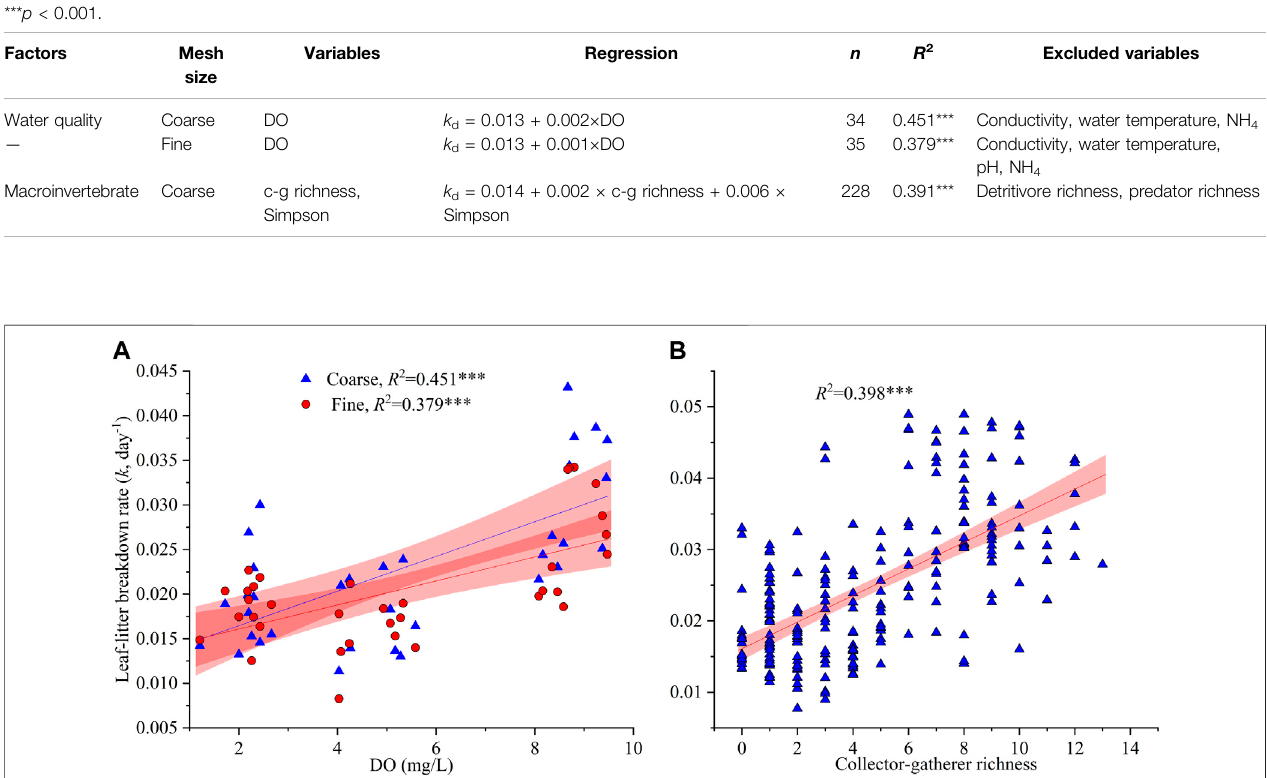
Frontiers in Environmental Science |